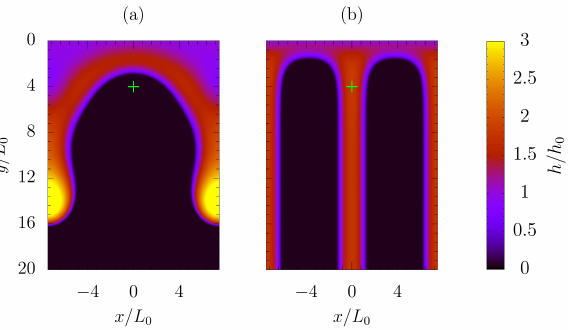
Figure 5. Film thickness solution at T = 11 ( a ); 2 rivulet configuration, steady state film distribution ( b ). Bo = 0.11, L X = 15, α = 60 ◦ , θ s = 60 ◦ (75 ◦ inside contamination spot, denoted by a green